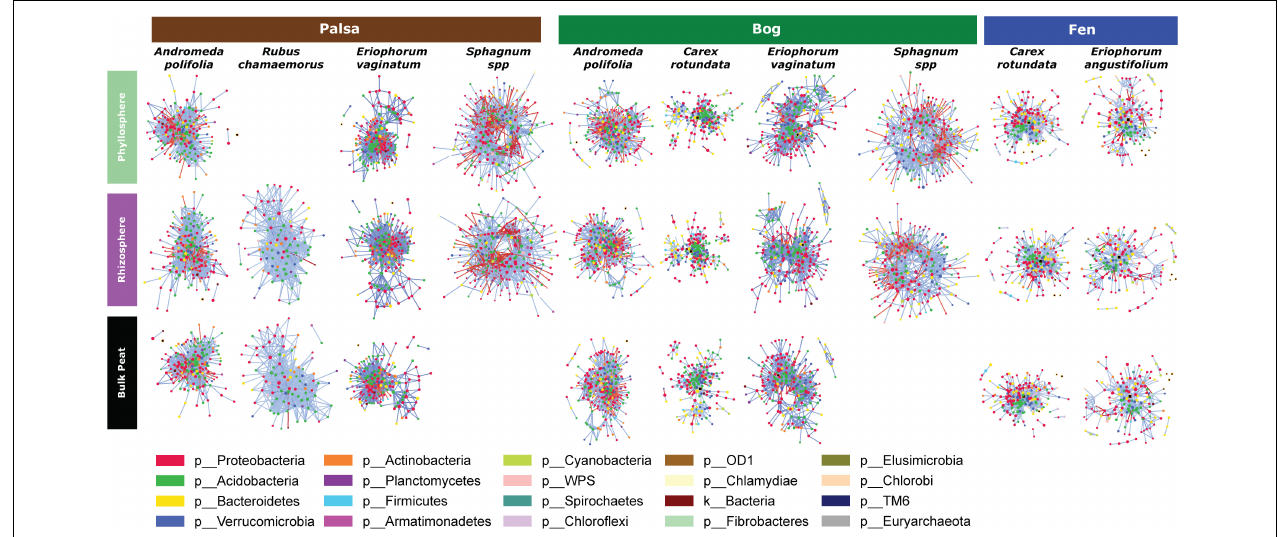
FIGURE 6 | Network diagrams of the microbial community associated with each sample type (separated by habitat, compartment, and plant associate). Blue lines indicate positive correlations and red lines indicate negative correlations. Colors indicate